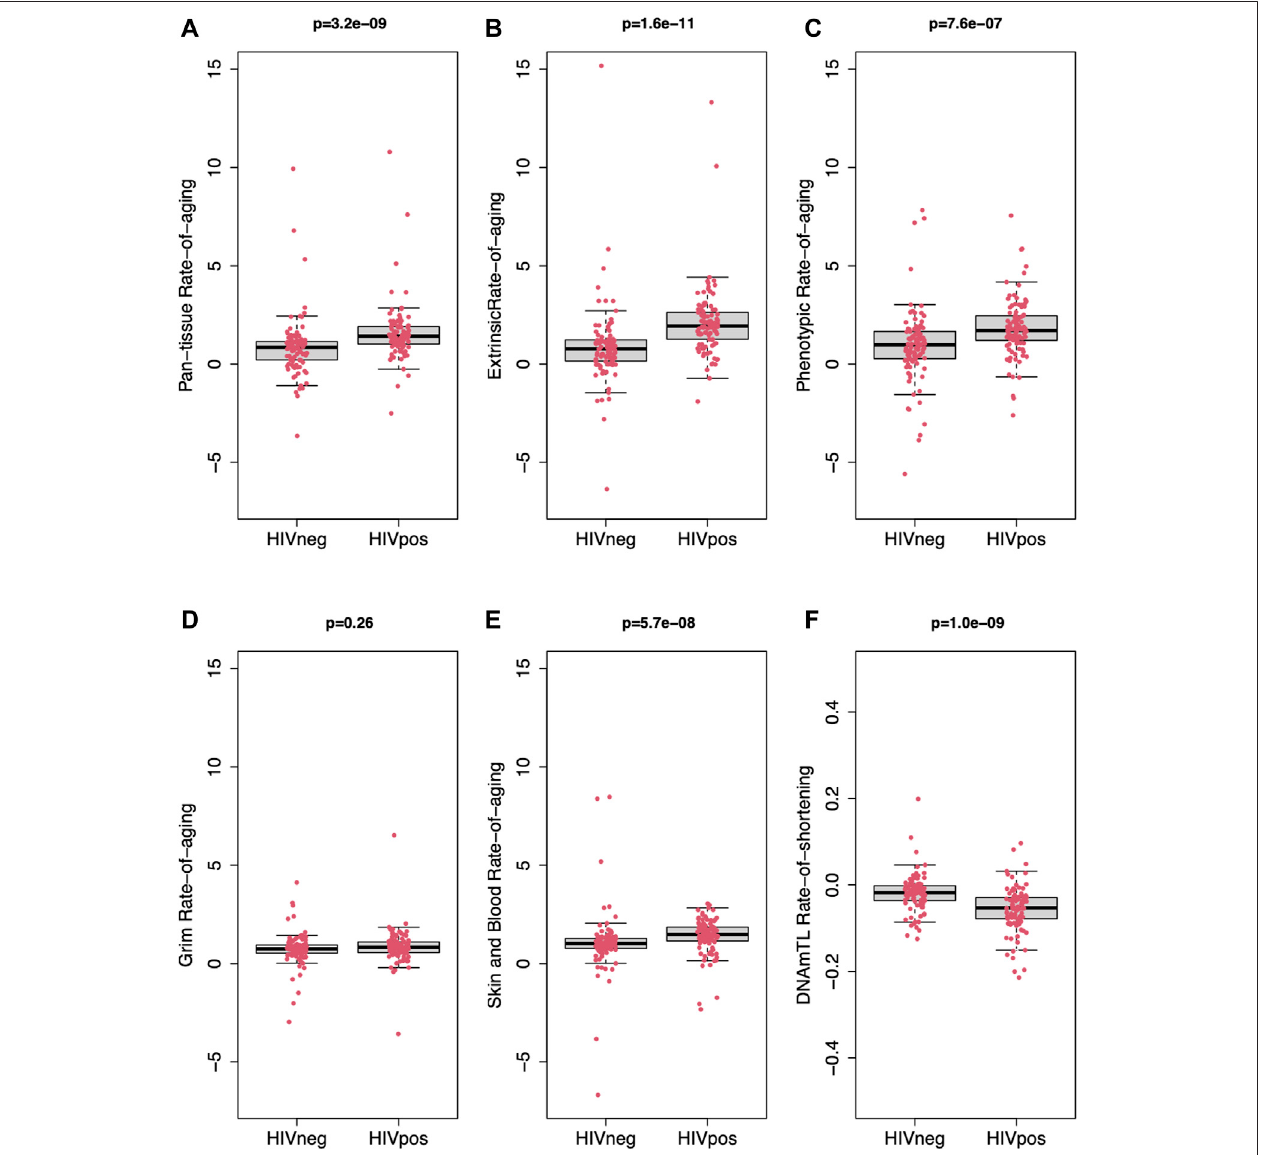
FIGURE 1 | Full distributions for rate-of-aging in peripheral blood mononuclear cells of HIV-infected participants (HIV POS, n (cid:2) 101) and uninfected controls (HIV NEG, n (cid:2) 100). Rate-of-aging, expressed as the ratio of (change in DNAm age)/(change in chronologic age), for each individual from Visit 1 to Visit 2, is shown on the y-axisforthePan-tissueclock[Panel (A) ],Extrinsicclock[Panel (B) ],Phenotypicclock[Panel (C) ],Grimclock[Panel (D) ],andtheSkin&Bloodclock[Panel (E) ].Rate-of- shortening in a methylation-based estimate of telomere length, DNAmTL, expressed as (change in DNAmTL)/(change in chronologic age) from Visit 1 to Visit 2, is showninPanel (F) .Theheavyblacklineindicatesthemedianvalue;boxesrepresent25th(Q1)to75th(Q3)percentile,whiskersrepresent5th – 95thpercentiles. p values shownareforthecomparisonbetweenHIV-infected anduninfectedmen(Welch ’ s t -test).They-axisofPanelFhasunitsofrelativeunitsperyearofchronologicage,and is accordingly on a different scale from that of the other